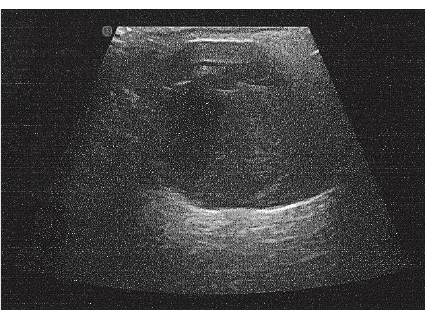
Figure 2: Scrotal ultrasonography with right ruptured implant and collapsed envelope.